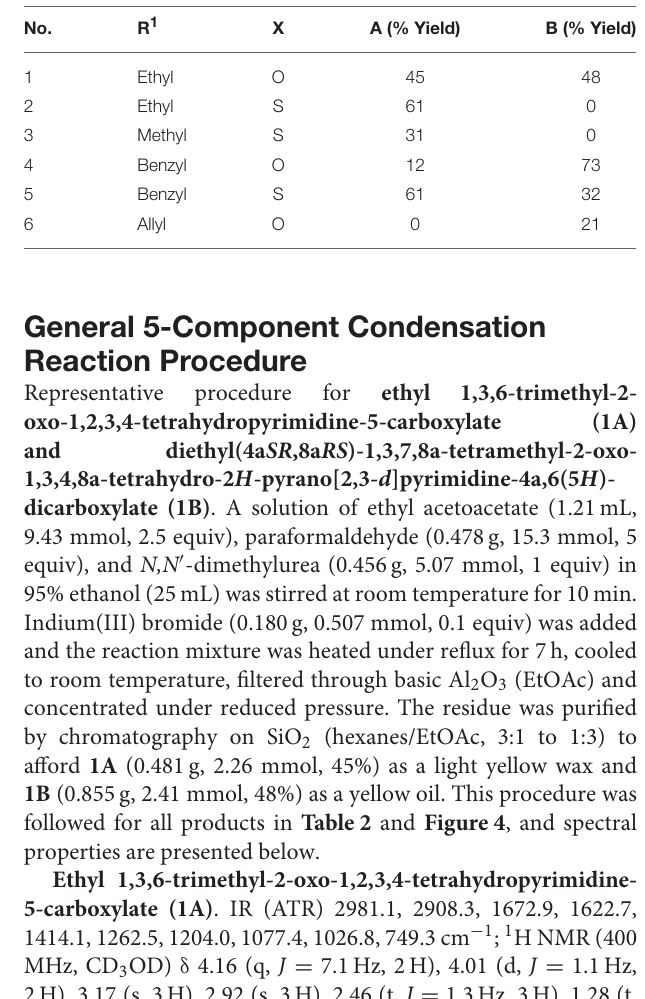
TABLE 2 | Reaction scope with formaldehyde, N,N ′ -dimethyl(thio)urea (X = O,S), and alkyl (R 1 ) acetoacetates. For products A and B, see Figure 2 . No.